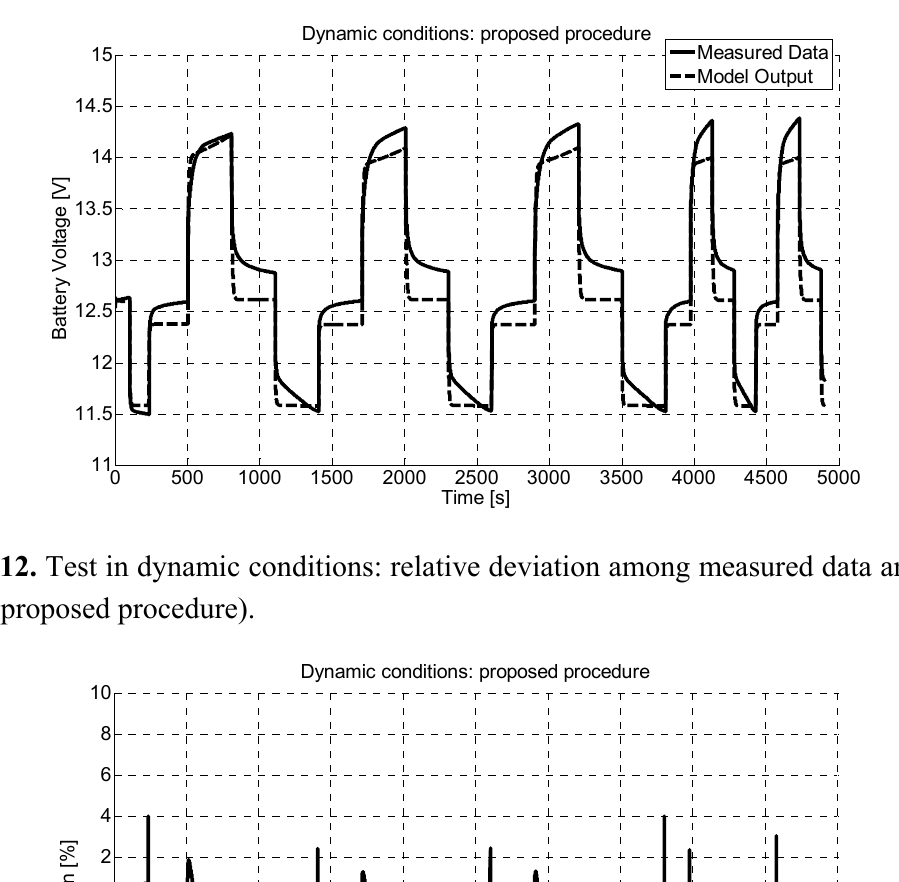
Figure 11. Test in dynamic conditions: measured battery voltage and model output with parameters from proposed procedure.